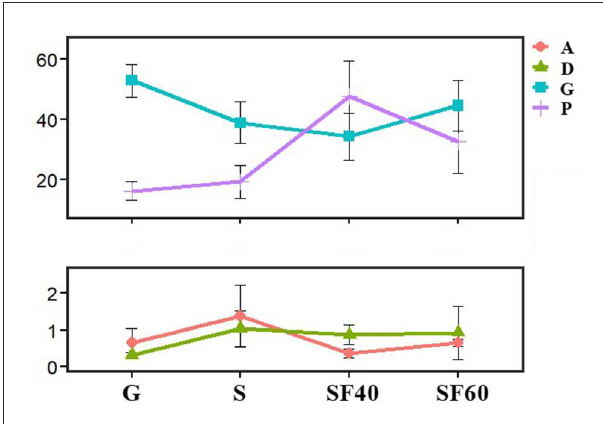
FIGURE3 The relative abundance of dominant AMF orders along successional stages. Error bars denote the standard deviation.